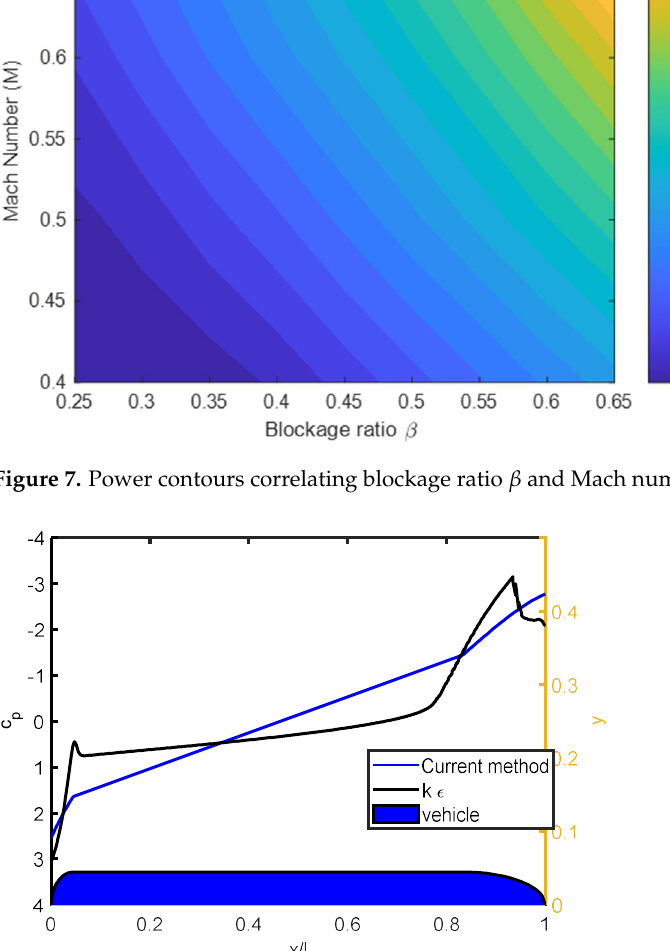
Figure 7. Power contours correlating blockage ratio (cid:2010) and Mach number, (cid:1868) = 10 kPa .